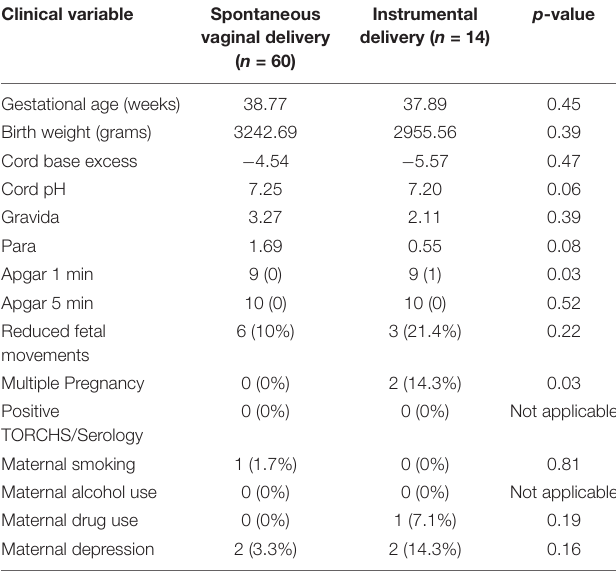
TABLE 7 | Subgroup comparison – babies born via normal vaginal versus instrumental delivery. Clinical